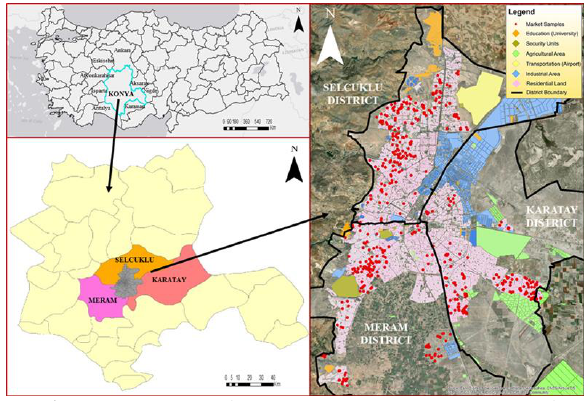
Figure 1 . Location of the study region and distribution of sampling